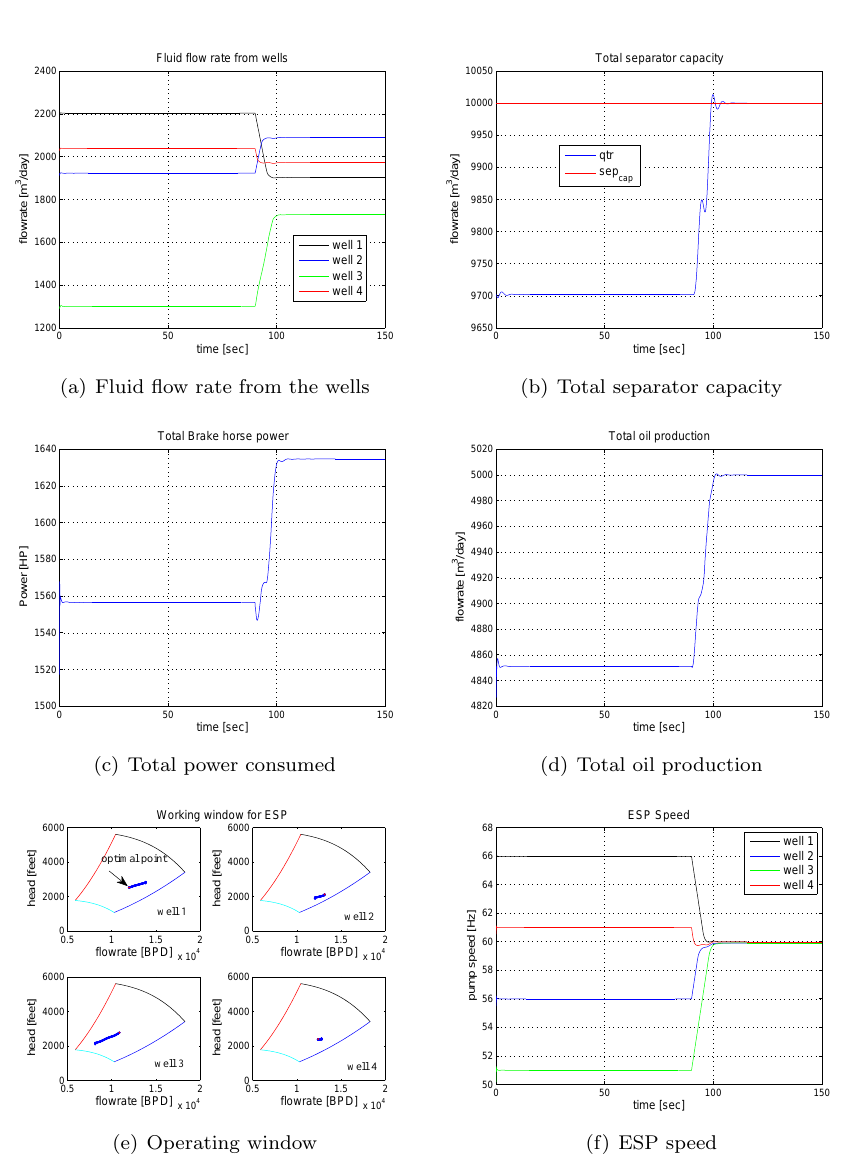
Figure 12: Optimal control of ESP oil field using one PI